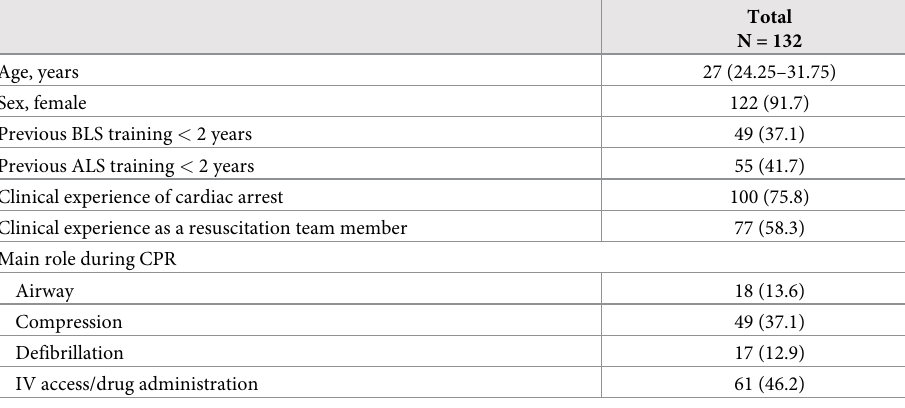
Table 1. Baseline characteristics of